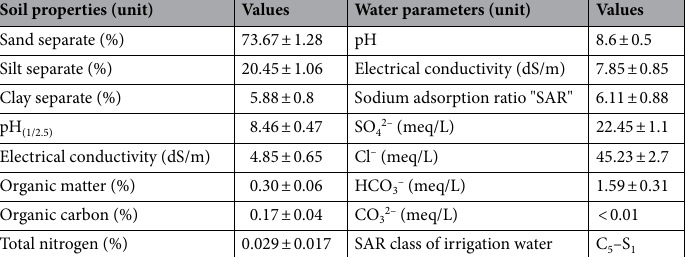
Table 1. Physicochemical properties (mean ± standard deviation) of soil (depth 0–60 cm) and irrigation water in study area for two cropping seasons (2017–2018 and 2018–2019).